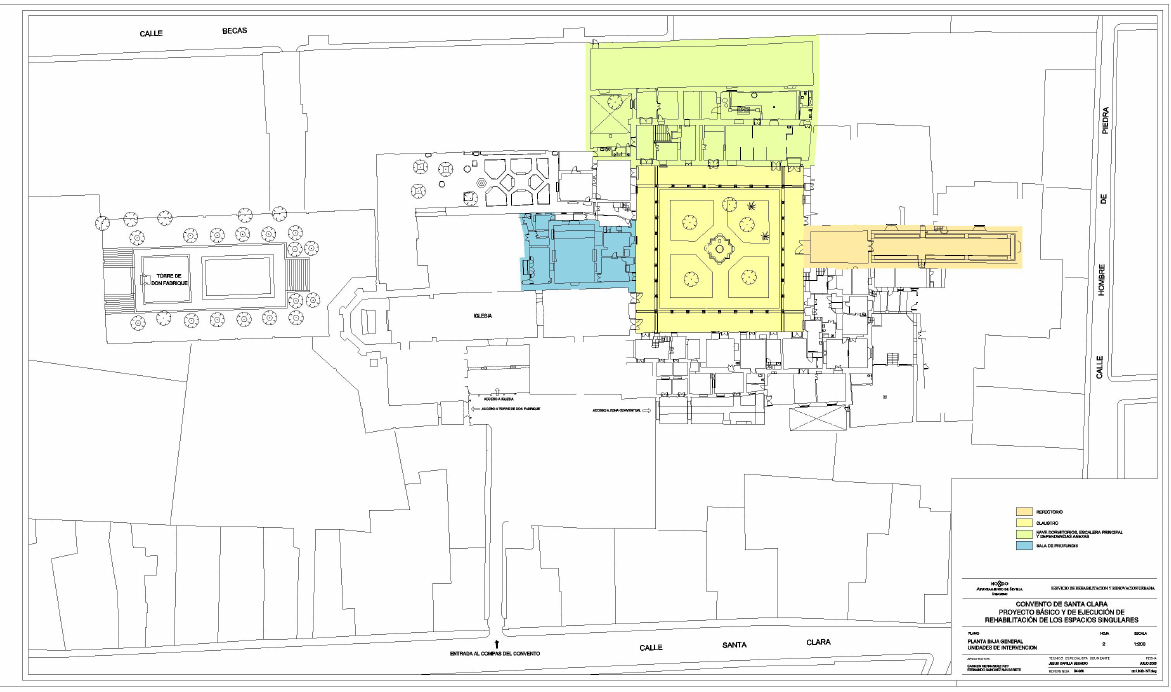
Figure 3: Refurbishment of the singular spaces of the convent of Saint Claire.